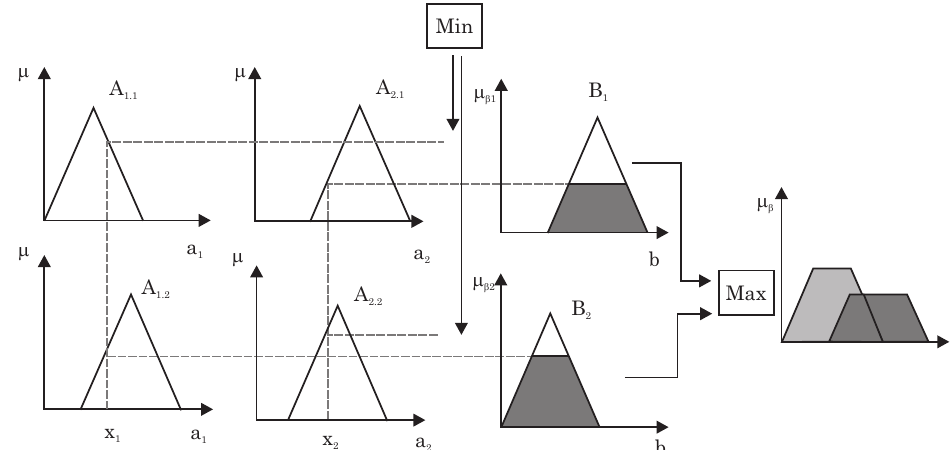
Figure 2. Maximum-minimum inference for the Mamdani model. Source: Saboya Jr. et al.